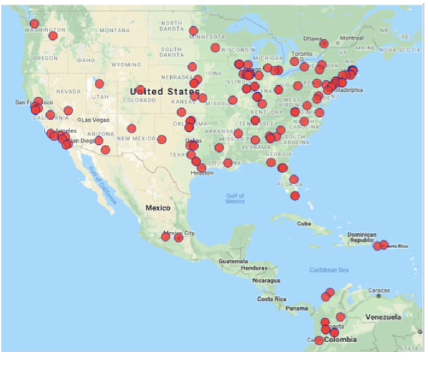
Figure 2. Geographical location of OSG computing